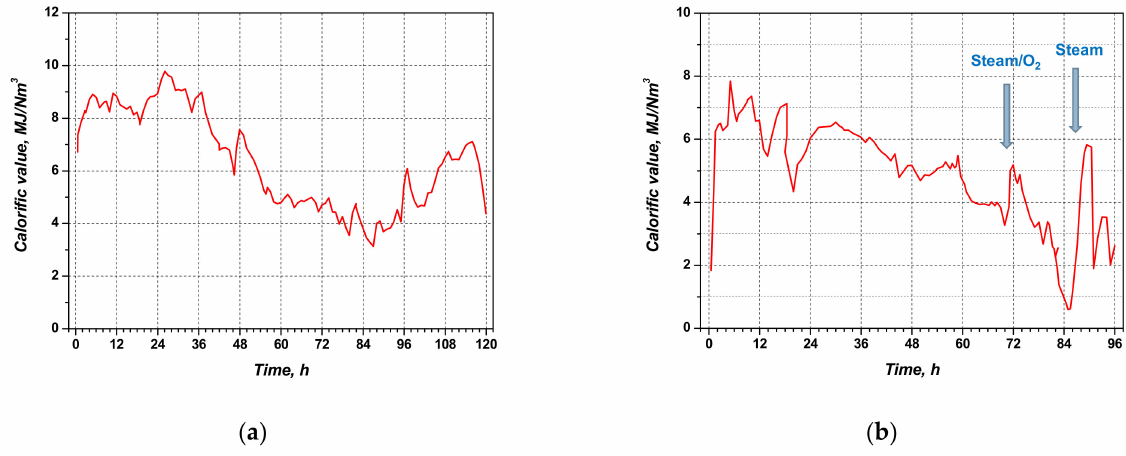
Figure 8. Changes in gas calorific value during the experiments: ( a ) Velenje lignite, ( b ) Oltenia